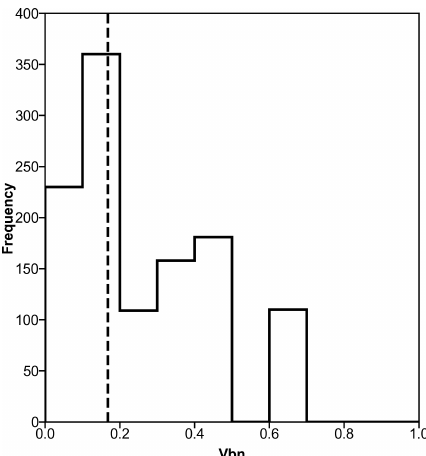
Figure 9. Cumulative beach-nourishment index ( V bn ), as of 2016, at transects (across all counties) that express both high “historical” and low “recent” rates of shoreline erosion (see Fig. 7a–d and m–p). The dotted line indicates the overall median V bn = 0 . 168 in 2016 for the full domain. For this component distribution, median V bn = 0 . 178 (mean = 0.251). This spatial correspondence between a major re- versal in shoreline-change trend (from erosion to accretion) and above-average nourishment intensity is an indication of a coupling between chronic erosion (hazard) and defensive intervention (vul-